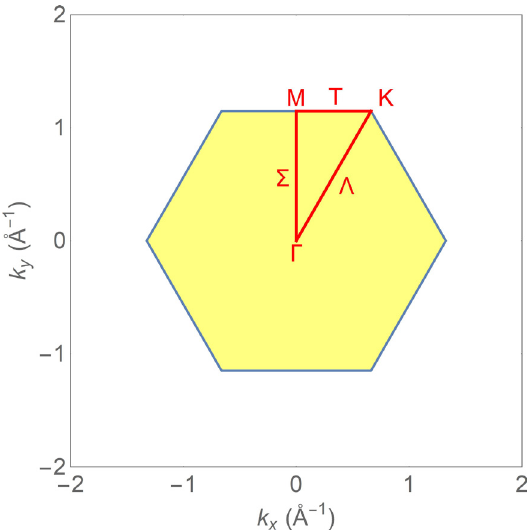
monolayer. The 2